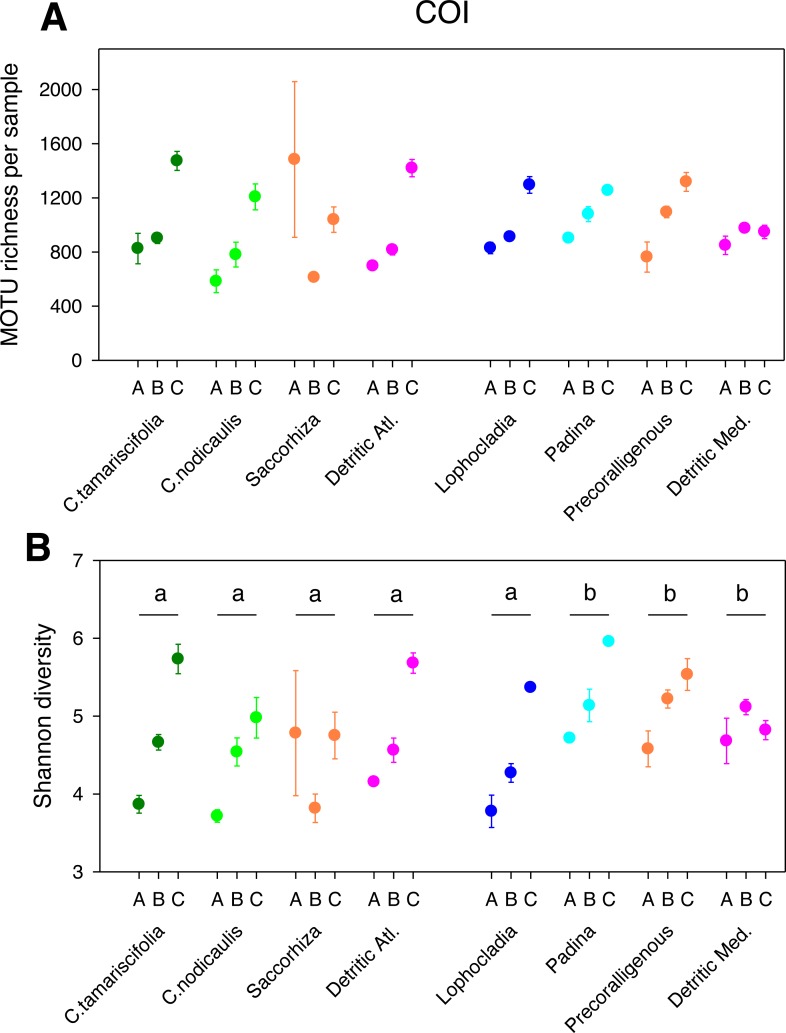
Scatter plots showing patterns of MOTU richness (A) and Shannon diversity index (B) for the COI gene.Results from eight different sublittoral communities (means ±  SE shown). Fraction A, coarse; B, intermediate; C, fine. MOTU richness results obtained by rarefaction analysis to 19,000 reads per sample. Whenever a significant community effect was found in the PERMANOVA analyses (Table 2), the letters above the communities represent groups not significantly different in a post-hoc pairwise test within each National Park.